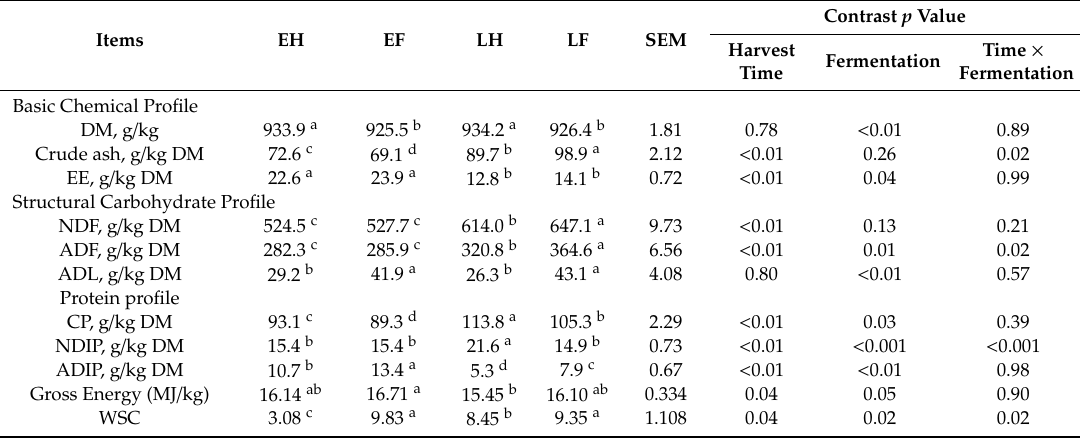
Table 3. E ff ects of harvest time and microbial anaerobic fermentation treatment on chemical profile of whole Zhang hybrid